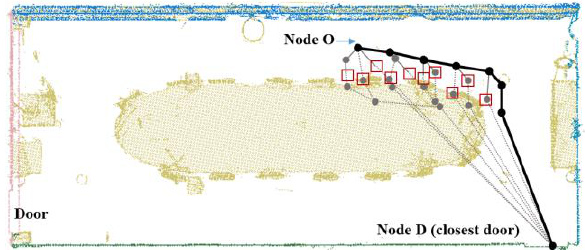
Figure 9: Attempts (grey) and result (black) of shortest path analysis for Route A.